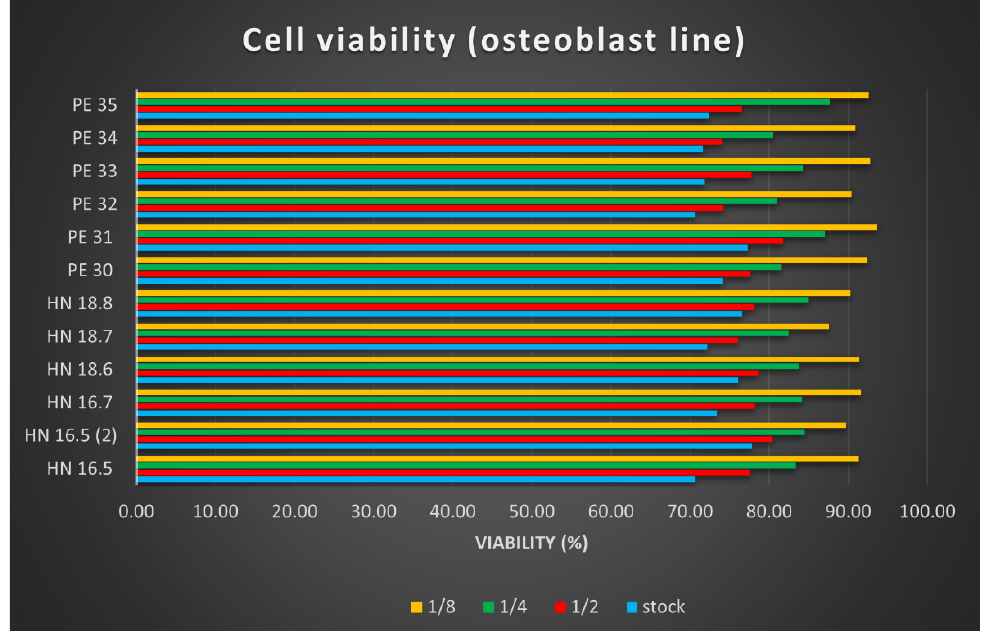
Figure 7. Cell viability of osteoblasts for the 12 HAp samples. The stock solution was diluted in binary dilutions (1/2, 1/4, and 1/8).